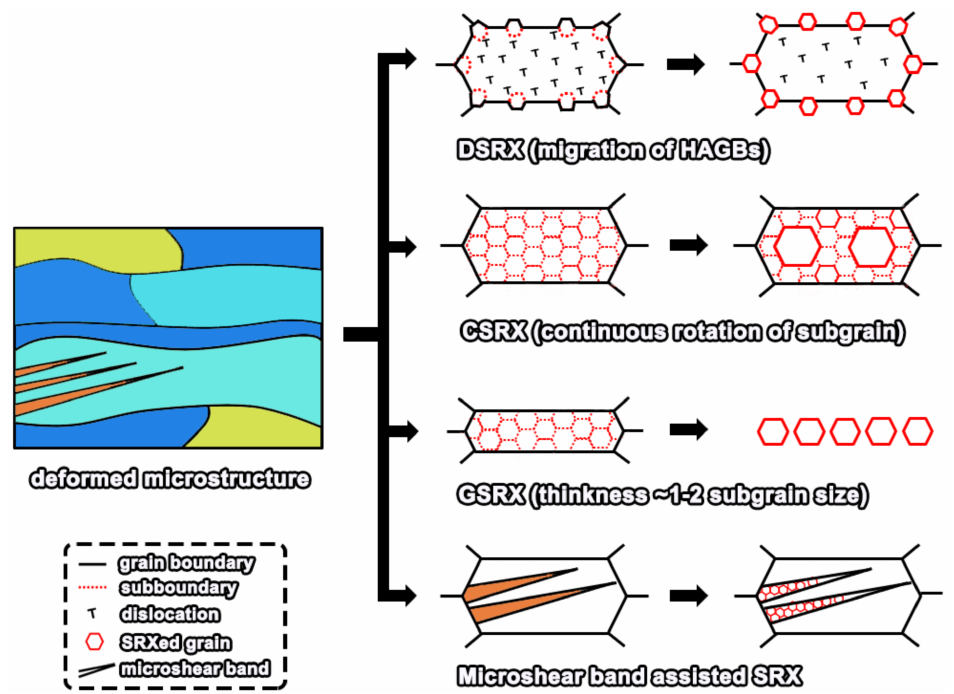
Figure 7. Schematic diagram of SRX mechanism of the cold rolling β Ti